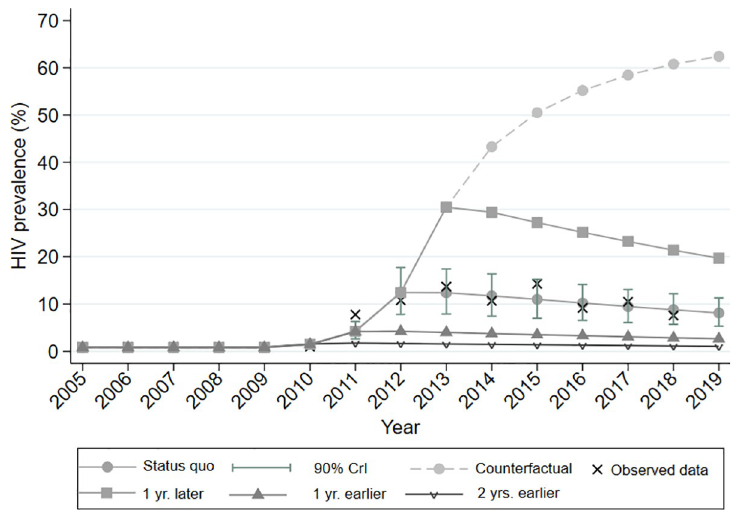
Fig 1. Model predictions for Human Immunodeficiency Virus (HIV) prevalence by the 5 different scenarios (status quo, counterfactual, one-year earlier/later implementation of interventions, and 2-year earlier implementation of interventions). The solid black line and shaded grey error bars show the median and 90% credible intervals (90% CrI) for the model projections. For comparison, asterisks indicate the observed HIV prevalence data.